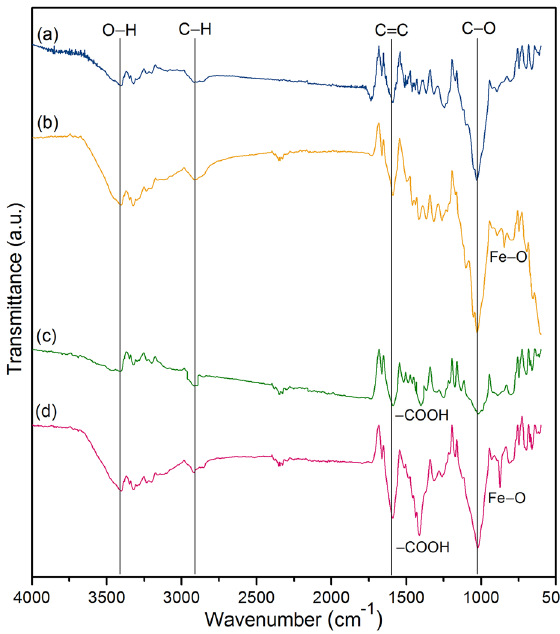
Figure 4. FT-IR spectra of ( a ) sawdust powder (SP), ( b ) sawdust powder doped iron (III) oxide-hydroxide (SPF), ( c ) sawdust beads (SPB), and ( d ) sawdust powder doped iron (III) oxide-hydroxide beads